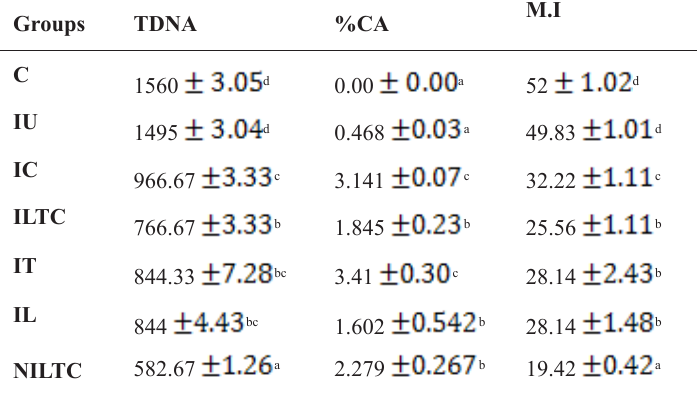
Table 6: Effects of administration of lumefantrine, trimethoprim and lumefantrine-trimethoprim-copper complex on the metaphasic status of chromosomes of the kidney of P. berghei NK-65 infected mice.